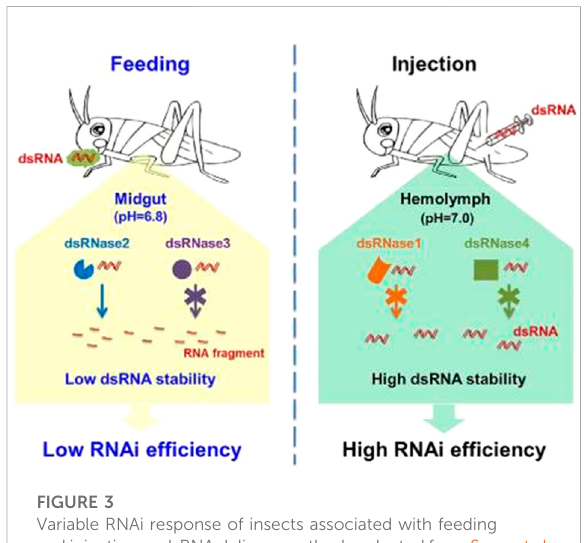
FIGURE 3 Variable RNAi response of insects associated with feeding and injection as dsRNA delivery methods, adaptedfrom Song et al.